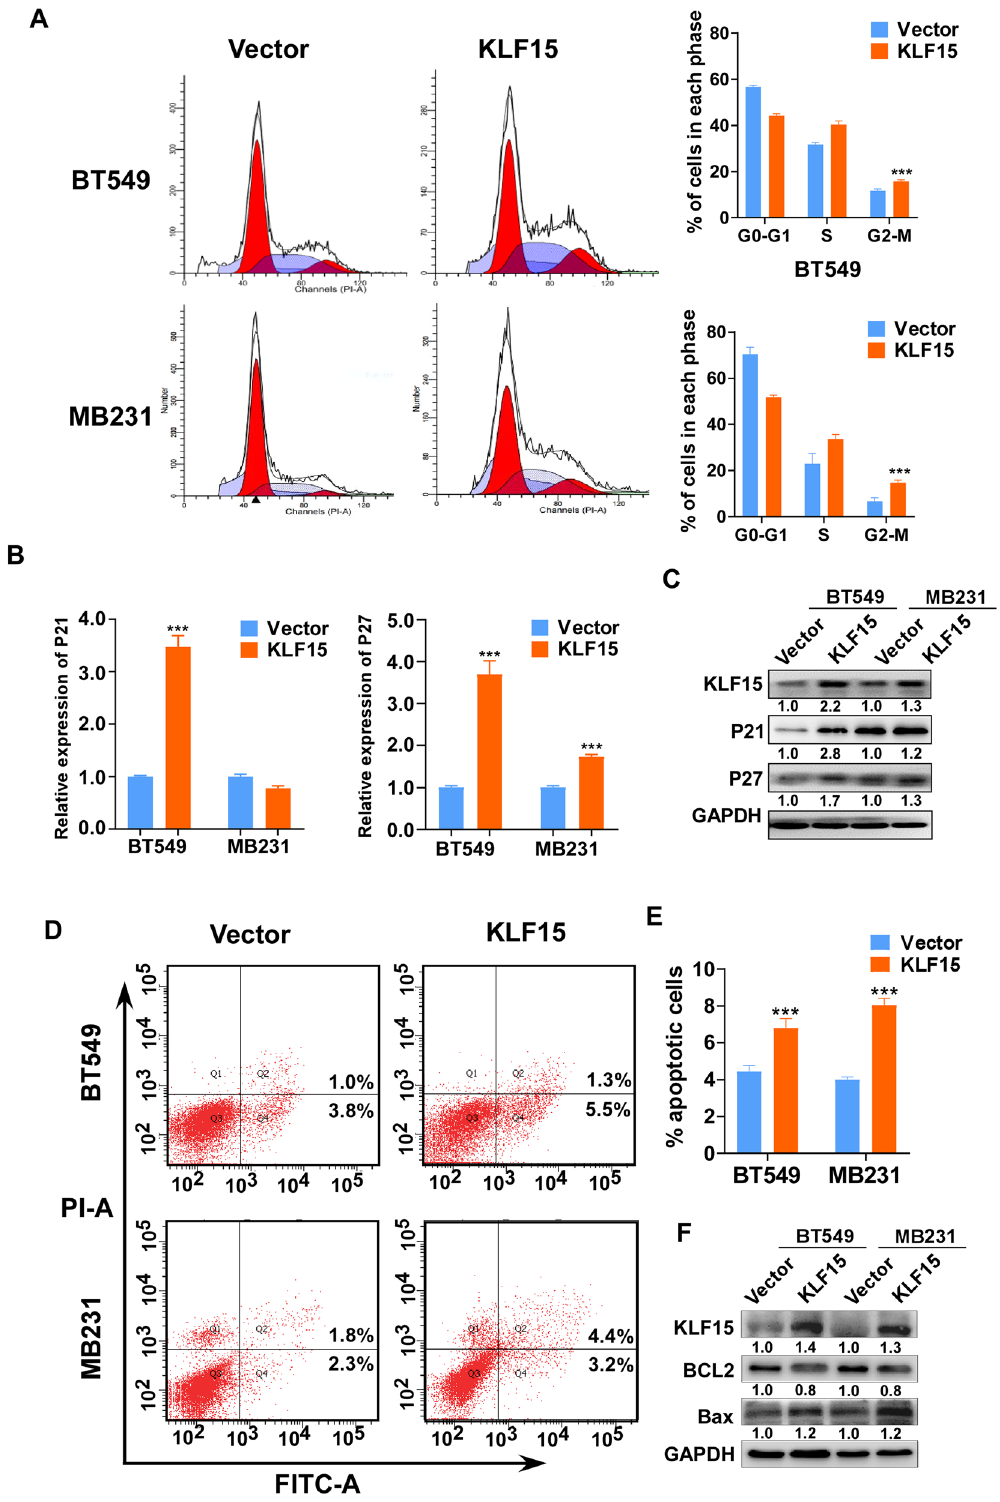
Figure 4. Exogenous KLF15 induces G2/M and S phase cell cycle arrest and promotes cell apoptosis in breast cancer cells. ( A ) Flow cytometry analysis was used to detect the effect of KLF15 on cell cycle in vector- and KLF15-expressing MDA-MB231 and BT549 cells. Left, representative flow cytometry results; right, histogram statistics of cell cycle changes. ( B , C ) RT-qPCR and Western blotting with primers and antibodies examining cell cycle associated regulators p21 and p27. ( D , E ) The proportion of apoptotic cells was detected in vector- and KLF15-expressing MDA-MB231 and BT549 cells by flow cytometry analysis. Representative flow cytometry plots and histogram statistics of apoptosis changes were exhibited. *** p < 0.001. ( F ) Western blotting detecting apoptosis related proteins, including Bcl-2 and